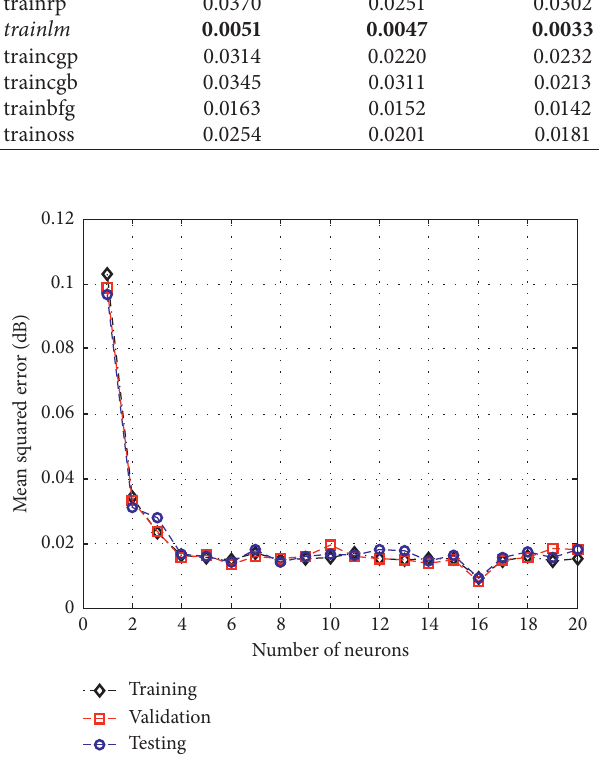
Figure 4: Performance of potential ANN models. Table 5: Details of the selected ANN